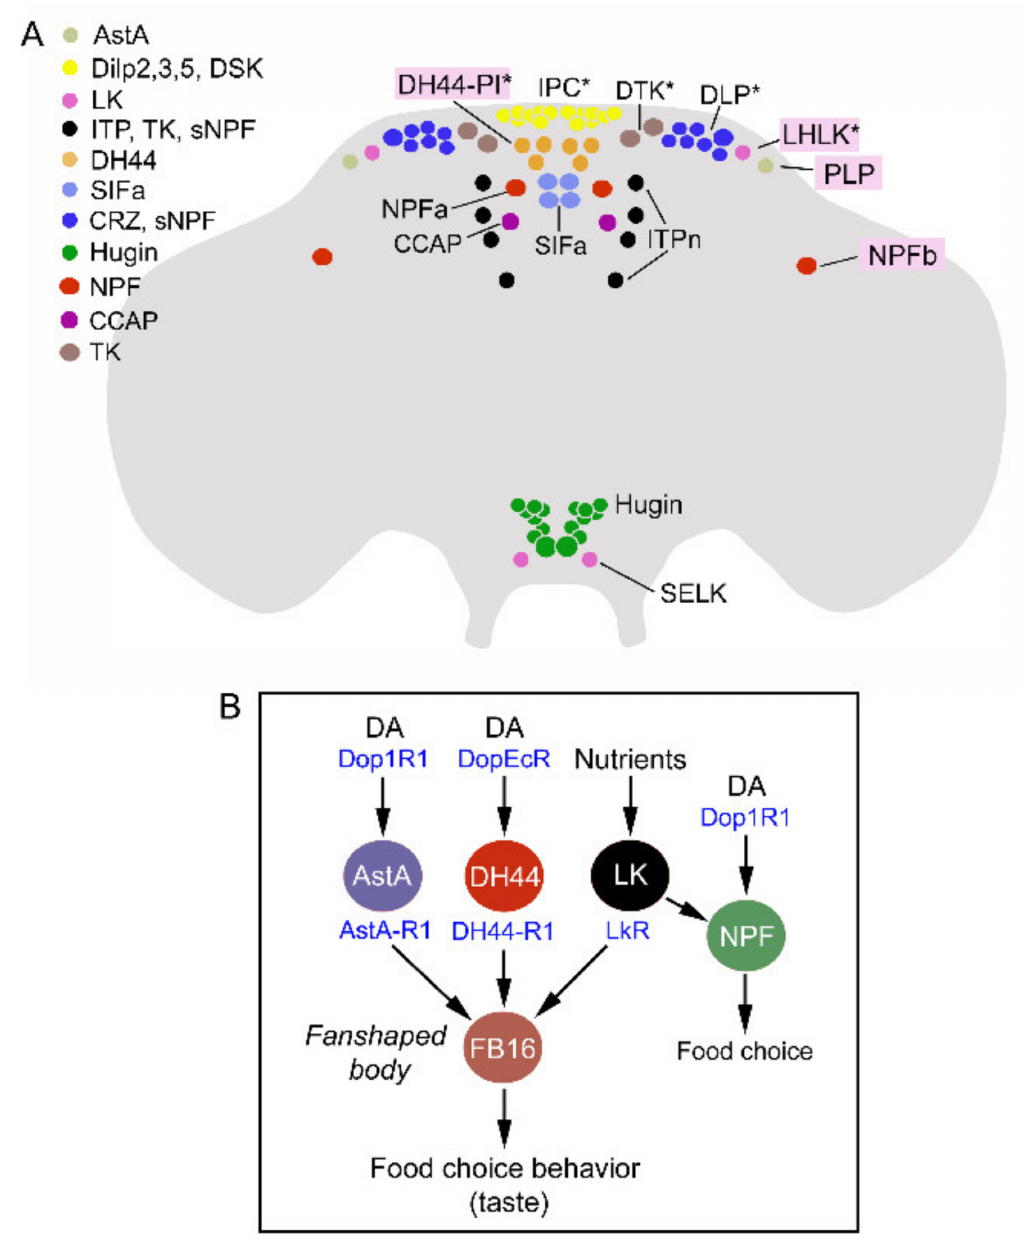
Figure 11. LK neurons and other peptidergic neurons that regulate food choice behavior and feeding. ( A ) Peptidergic neurons and neurosecretory cells that have been implicated in nutrient sensing, food choice and feeding behavior. The neurons highlighted with pink boxes are discussed in Figure 10B. Asterisks indicate that neurons are nutrient sensing. The peptides are as follows: AstA, allatostatin A; DSK, drosulfakinin; ITP, ion transport peptide; TK, tachykinin: sNPF, short neuropeptide F; SIFa, SIFamide; CRZ, corazonin; Hugin, hugin-pyrokinin; NPF, neuropeptide F; CCAP, crustacean cardioactive peptide. Data used for compilation of this figure are from [1,7,141–145]. ( B ) The nutrient-sensitive LHLK neurons (represented by LK) act on neurons (FB16) innervating the fan-shaped body (FSB). Additional neurons converge on the FB16 neurons to regulate food choice: neurons producing allatostatin A (AstA), and diuretic hormone 44 (DH44). Neuropeptide F (NPF) neurons also act on FB16 neurons to regulate food choice. The AstA, DH44 and NPF neurons receive inputs from dopaminergic neurons (DA) via two of the DA receptors, Dop1R1 and DopEcR. This figure was redrawn from